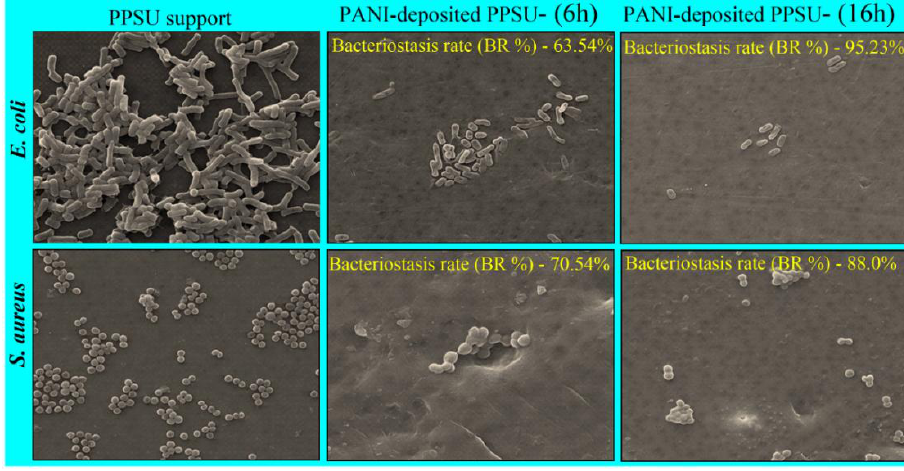
Figure 11. SEM images of features in at 5 kV, 1000 X, 6.5 WD collected to evaluate adhesion and the morphologies of E. coli and S. aureus cells on pristine PPSU and PANI-coated PPSU membranes after incubation for 6 h and 12 h.